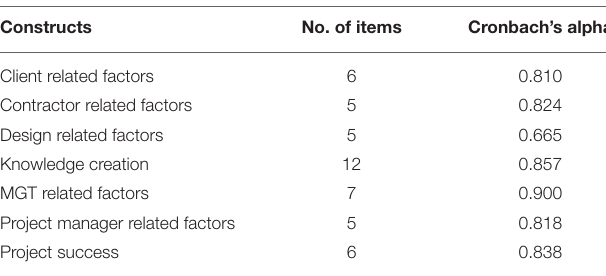
TABLE 2 | Pilot testing